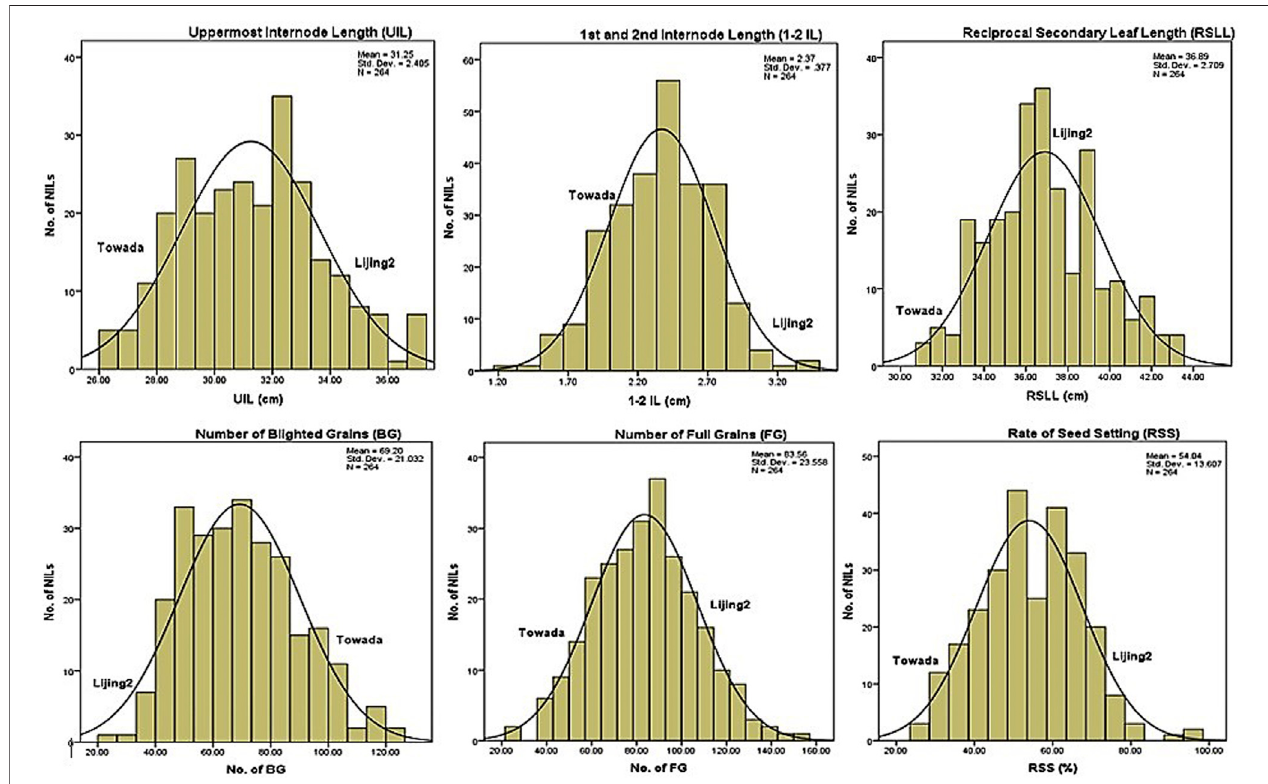
FIGURE 1 | Frequency distribution of cold stress tolerance traits based on growth (UIL, 1-2 IL, RSLL) and yield (BG, FG, RSS) related attributes of NILs of Towada brown rice.